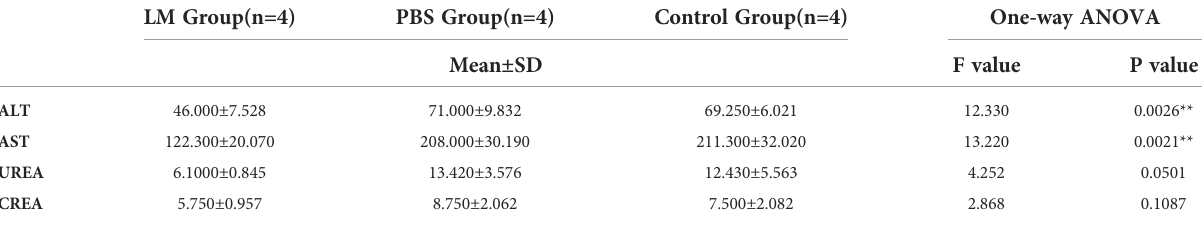
TABLE 3 The statistical results of serum biochemical tests among three